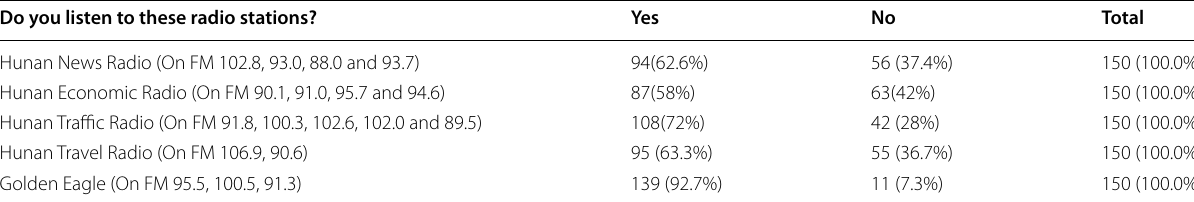
Table 9 Frequency, percentage of statement of listenership strength of radio stations (Audience response) Do you listen to these radio